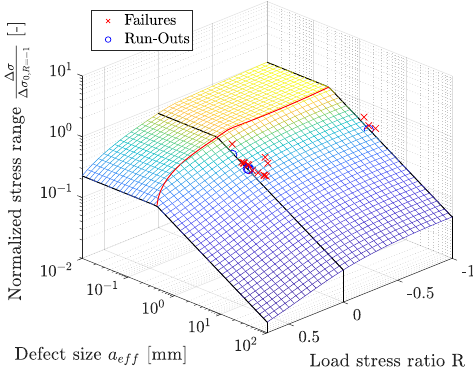
Figure 24. GKD for FT#A defects enhanced by the mean stress effect.